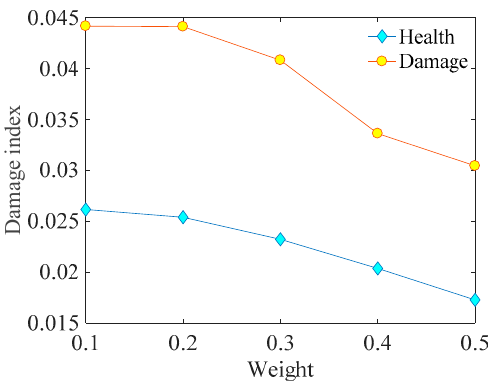
Figure 10. The DI value changes with weight .